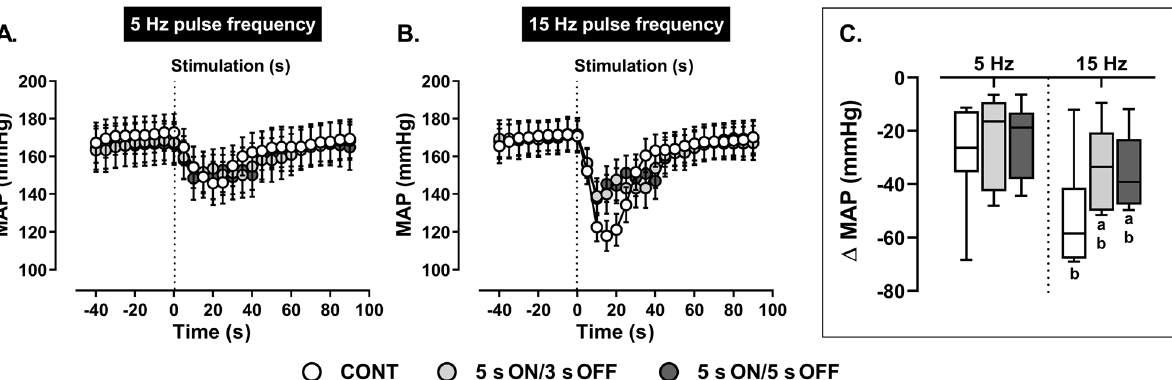
Figure 3. Effect of ( A ) low (5 Hz) and ( B ) high (15 Hz) frequency continuous (CONT) versus intermittent (5 s ON/3 s OFF and 5 s ON/5 s OFF) aortic depressor nerve (ADN) stimulation (0.4 mA, 0.2 ms for 20 s) on reflex reductions in mean arterial pressure (MAP) in pentobarbital-anesthetized spontaneously hypertensive rats. ( A,B ) The time trend for reflex depressor responses to ADN stimulation, while ( C ) shows absolute changes (mmHg) in MAP in response to ADN stimulation. Results are expressed as mean ± SEM ( n = 9), analyzed by a two-way ANOVA followed by Bonferroni’s post hoc test. a: P < 0.05 versus continuous stimulation for each frequency and b: P < 0.05 versus respective stimulation across frequencies.